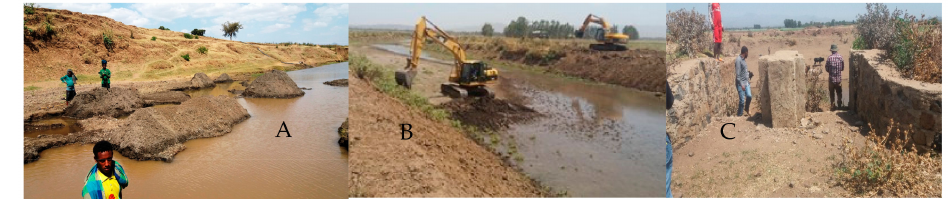
Figure 8. ( A ) excavated sand accumulation by sand miners in the Middle River reach; ( B ) river channel enlargement and deepening to increase flow conveyance. The contractor used the material for embankment construction at the Lower reach; ( C ) flood outlet structure to the farmlands as low height weir (April 2016).